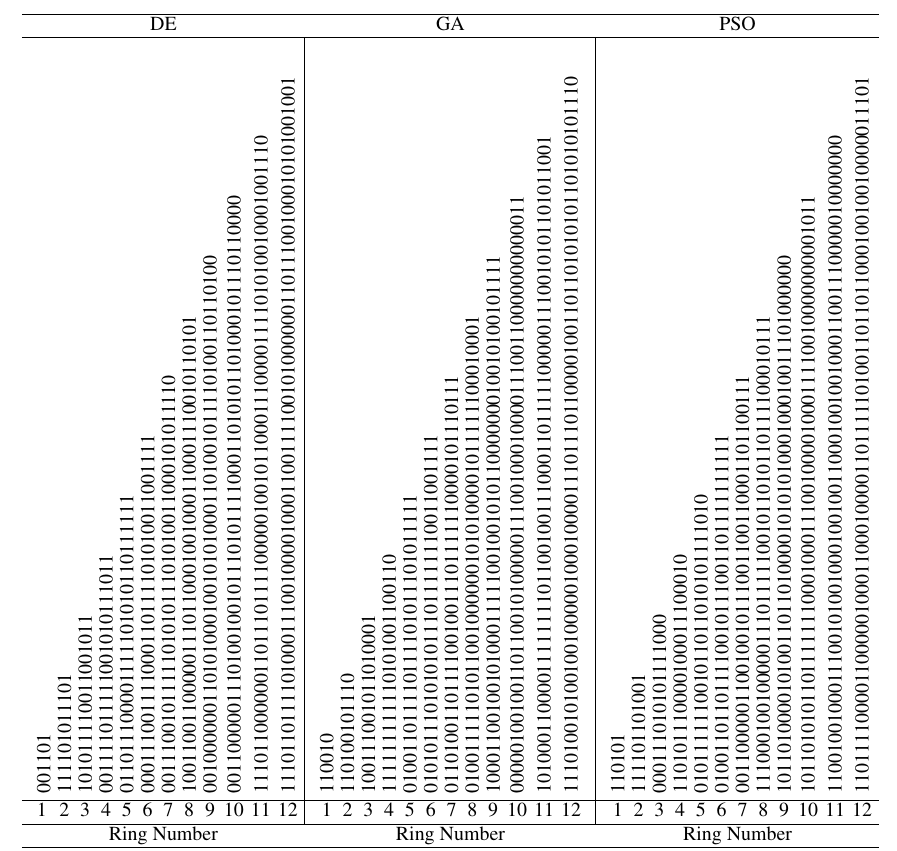
TABLE 2: Excitation Amplitude distribution ( I mn ) of thinned array